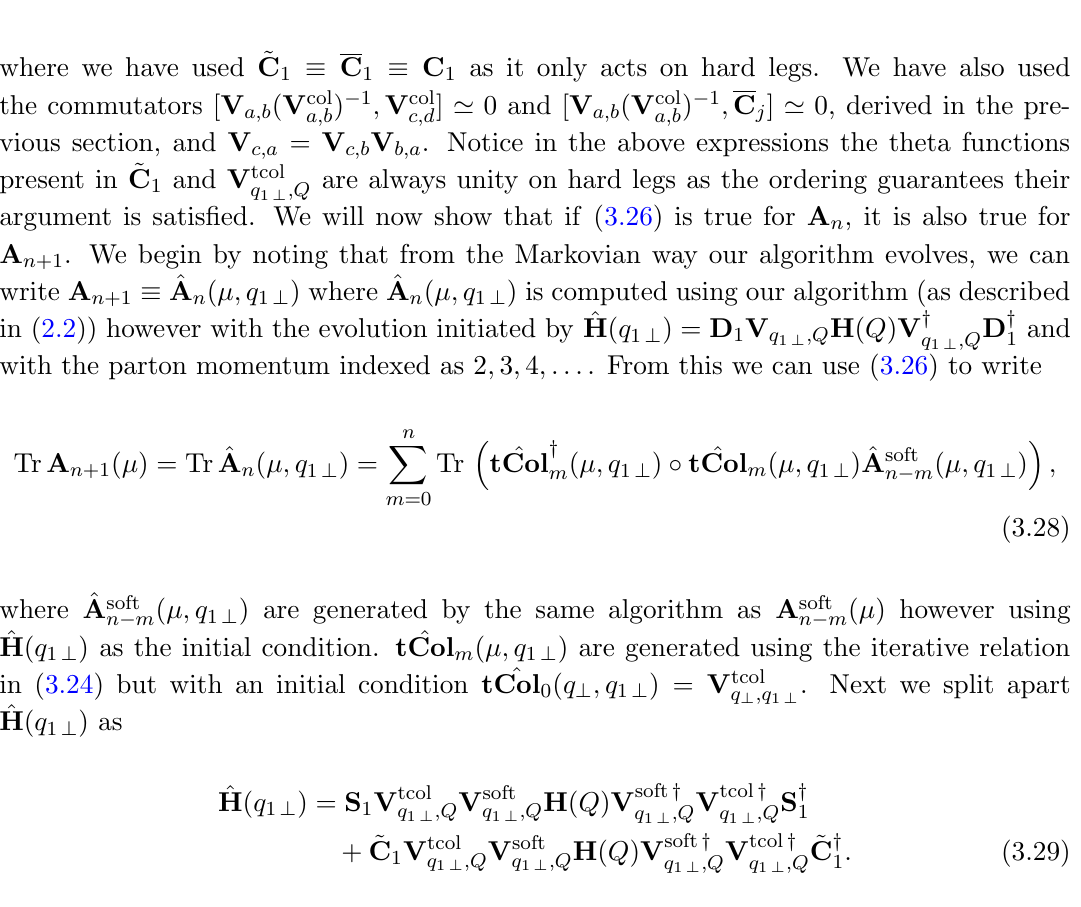
Figure 6. A diagram illustrating factorised parton evolution. Red dashed lines represent the emission of soft gluons and blue dotted lines represent collinear emissions. Circles represent the hard scale from which the subsequent evolution proceeds. Loops (Sudakov factors) have not been